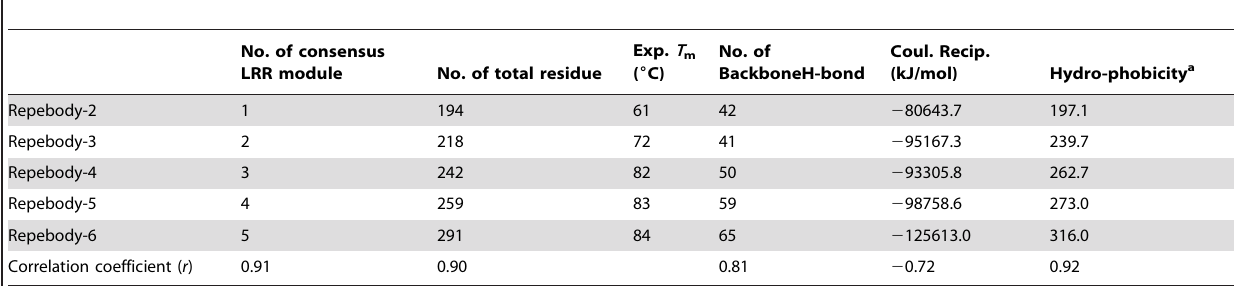
Table 1. Correlation between melting temperature T m and intramolecular interaction properties including number of backbone H- bond, energies, and hydrophobicity.